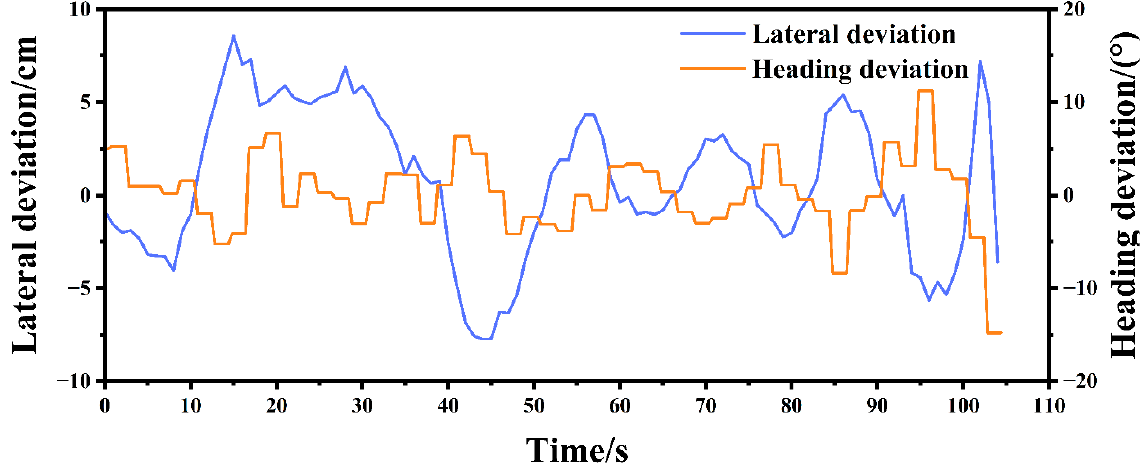
Figure 13. The diagram of the lateral and heading deviation.